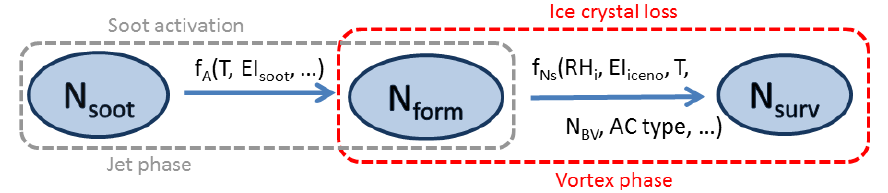
Figure 1. From soot emission to contrail ice crystal number: number of emitted soot particles N soot , generated ice crystals N form and ice crystals N surv present after vortex break-up and relevant for contrail-to-cirrus transition. f A denotes the fraction of activated soot particles (during the first seconds behind the aircraft), and f Ns the fraction of ice crystals surviving the adiabatic heating during the vortex phase (during the first ∼ 5min). The displayed quantities have units per metre (of flight path), which can be converted into emission indices following Eq. (2) and analogous expressions. The present study focuses on the loss process during the vortex phase (red box). For soot-poor regimes (i.e. much lower than present-day EI soot values), contrail ice crystals originate mainly from ultrafine liquid and entrained ambient particles and the simple picture expressed by N form = f A × N soot in the grey box is not valid any longer (Kärcher and Yu, 2009).